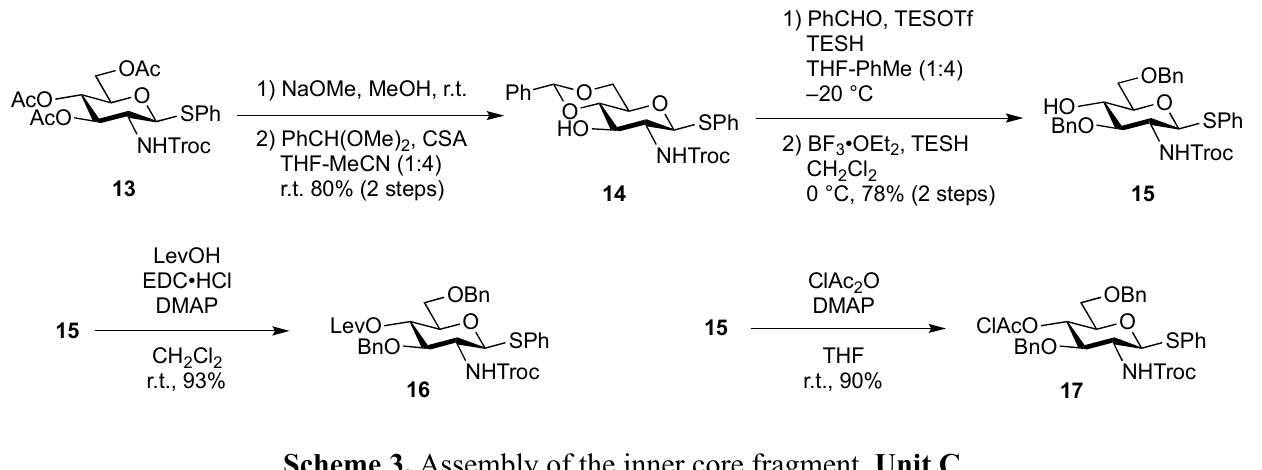
Scheme 3. Assembly of the inner core fragment, Unit C